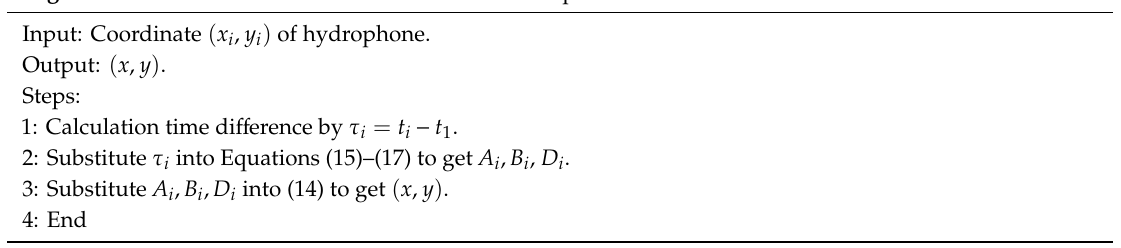
Algorithm 1 TDOA measurements in 2-D underwater